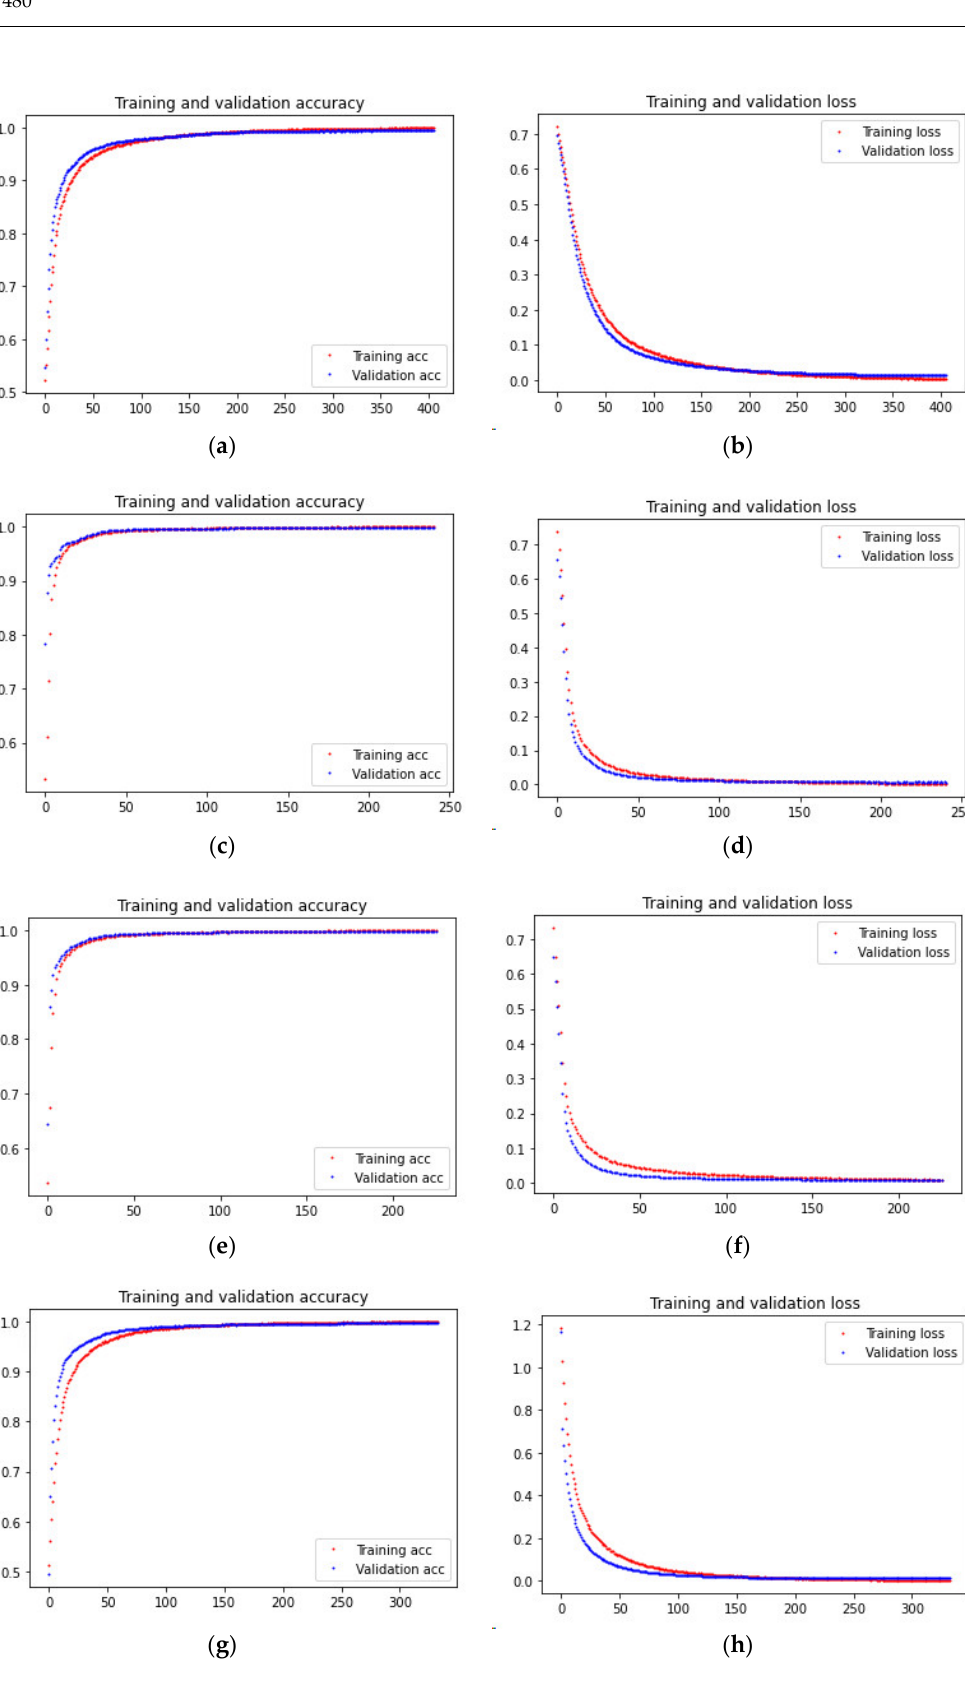
Figure 13. Comparison of training and validation results in various transfer learning models should be listed as: ( a ) Xception accuracy; ( b ) Xception loss; ( c ) VGG16 accuracy; ( d ) VGG16 loss; ( e ) VGG19 accuracy; ( f ) VGG19 loss; ( g ) ResNet50 accuracy; ( h ) ResNet50 loss.